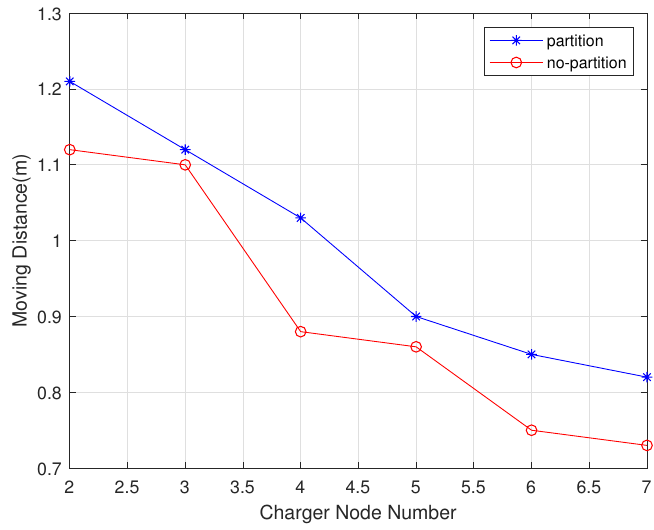
Figure 20. Charger node distance varies with charger number.